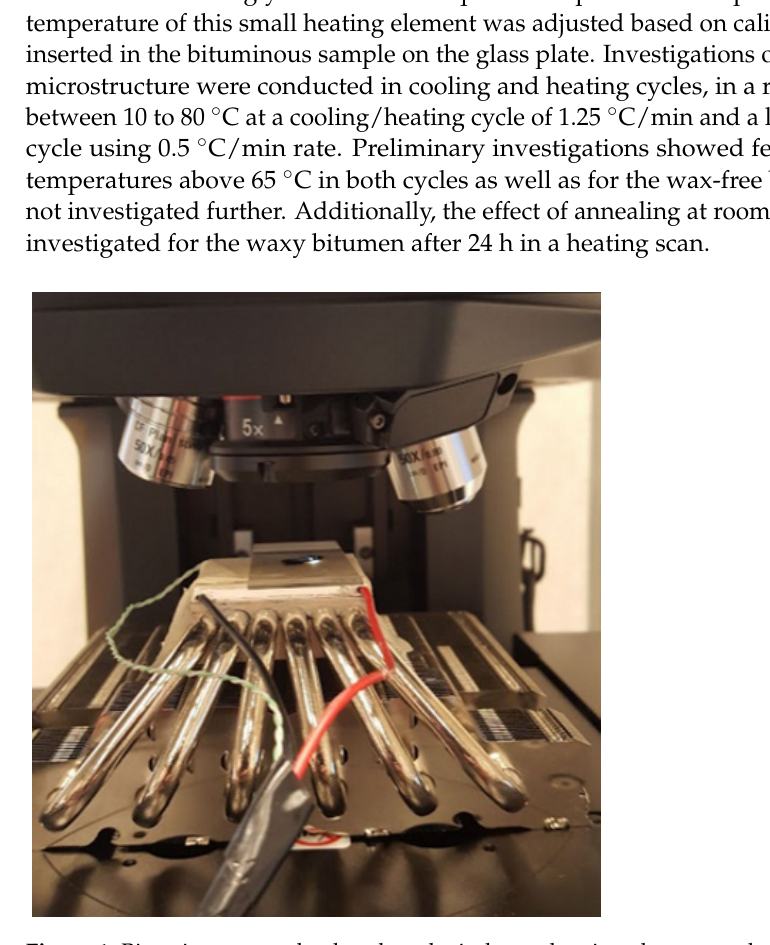
Figure 1. Bituminous sample placed on the in-house heating element under